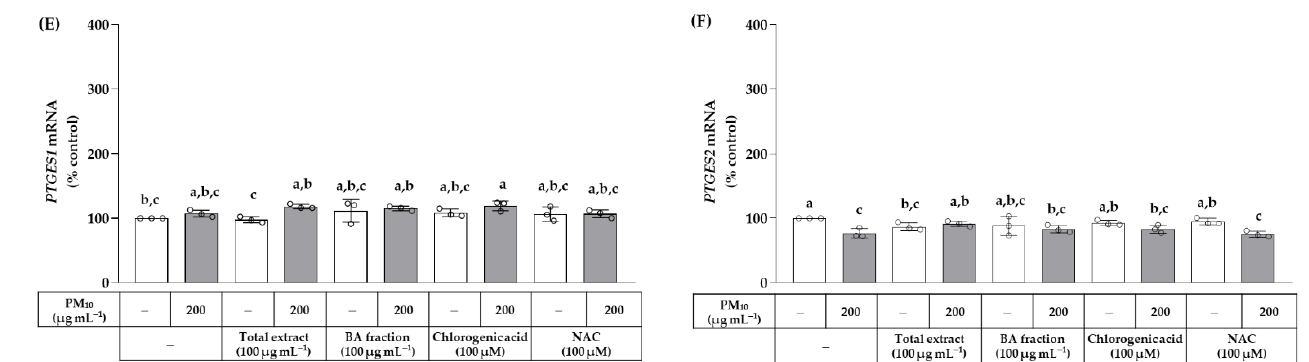
Figure 8. Effects of the total OJ extract, its BA fraction, chlorogenic acid, and NAC on the mRNA expression levels of phospholipase A2 group IIA ( PLA2G2A ) ( A ), phospholipase A2 group IVA ( PLA2G4A ) ( B ), prostaglandin-endoperoxide synthase 1 ( PTGS1 ) ( C ), prostaglandin-endoperoxide synthase 2 ( PTGS2 ) ( D ), prostaglandin E synthetase 1 ( PTGES1 ) ( E ), and prostaglandin E synthetase 2 ( PTGES2 ) ( F ) in HaCaT keratinocytes exposed to PM 10 . Cells were treated with the total extract (100 μg mL −1 ), BA fraction (100 μg mL −1 ), chlorogenic acid (100 μM), and NAC (100 μM), alone or in combination with PM 10 (200 μg mL −1 ), for 24 h. The mRNA expression level of each gene was analyzed by the quantitative reverse transcriptase-polymerase chain reaction (qRT-PCR) and normalized to that of glyceraldehyde 3-phosphate dehydrogenase ( GAPDH ). Data are presented as % of control (means ± SD, n = 3). Groups that do not share the same lowercase alphabet letters (a–c) have statistically different means at the p < 0.05 level.